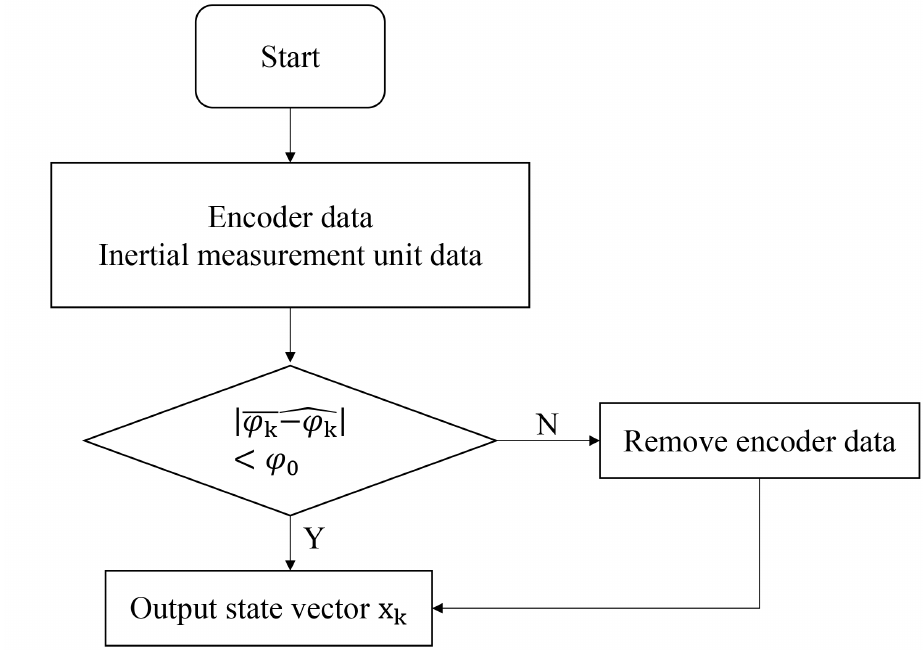
Figure 12. The EKF data